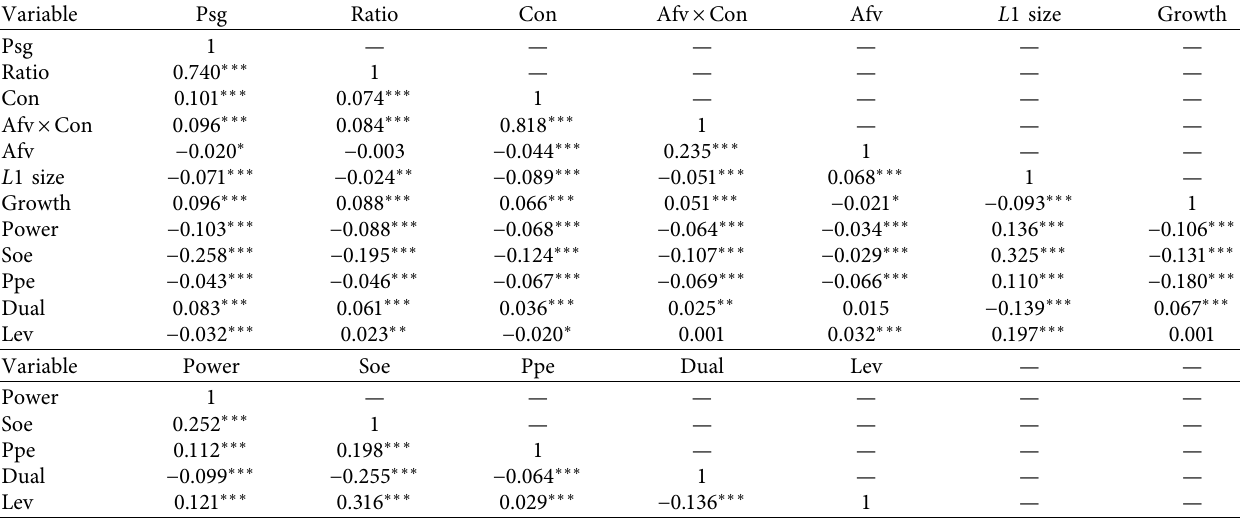
Table 2: Pearson coefficient test.